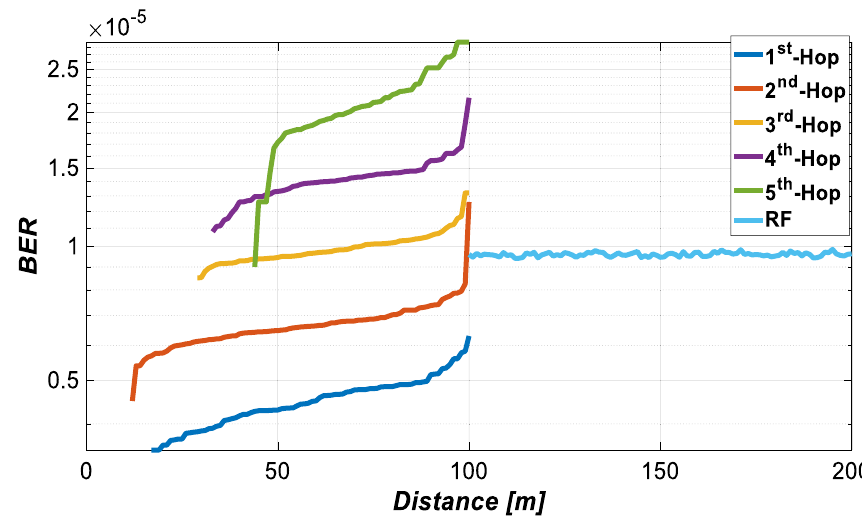
Fig. 6 The BER versus distance. In VLC communication, increasing the distance leads to higher BER until approximately 100 m (i.e., the maximum allowed distance for VLC communication) in each hop. In VLC first hop, a small BER is noticed, in the second hop, the error increased due to the repeater amplify and forward scheme errors, while at higher hops have higher max errors. In contrast, RF communication has near-constant BER at distances from 100 m (i.e., after the VLC hop maximum communication distance) up to 200 m. We consider no communication at distances greater than 200 m to ensure the minimized interference in RF (omnidirectional radiation pattern) and to maximize the frequency reuse in car-to-car RF